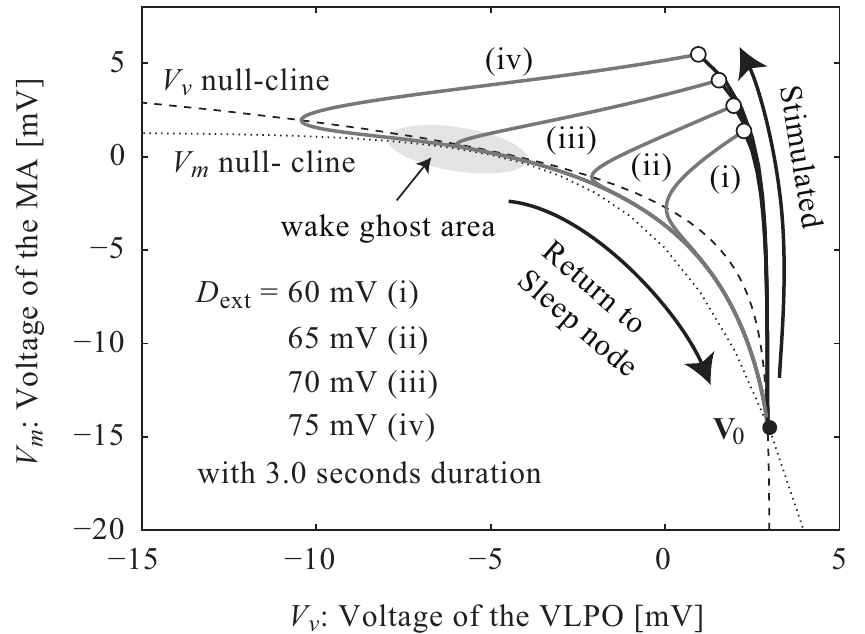
Figure 2. The behavior of the potential, V p t q , in response to external stimuli. The nullclines of V v and V m and their intersection, V 0 , were obtained from Equation (2). V p t q moves upward in response to a stimulus (thick black line) before returning to V 0 (grey